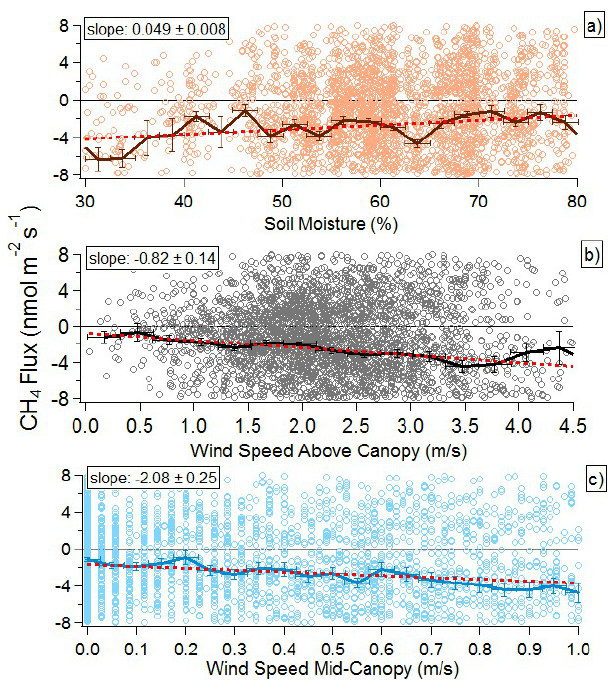
Fig. 8. Scatterplot of CH 4 fluxes with soil moisture (a) , and wind speed above canopy (b) and mid-canopy (c) with a line of best fit (red dashed line), error bars indicating standard deviation of the mean (vertical), and size of the bin (horizontal). Dashed red line is a linear regression through the data, with the slope ± 2 σ reported for each panel. For each of the three panels, the respective p value is <